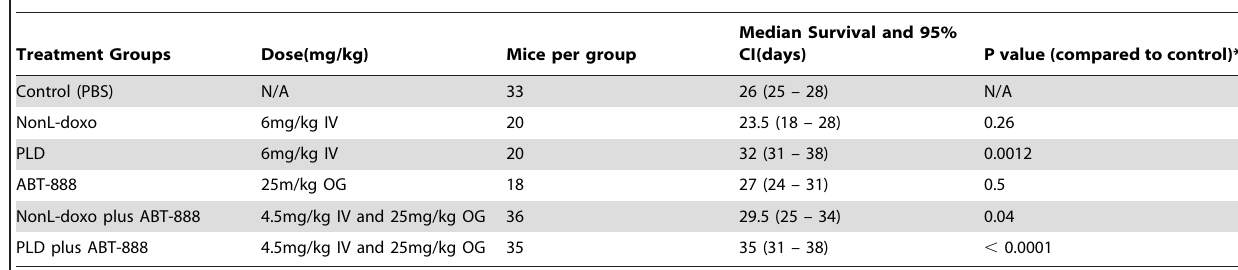
Median Survival of an intracranial breast cancer model treated with Control (PBS), non-liposomal doxorubicin (NonL-doxo) versus PEGylated Liposomal Doxorubicin (PLD). *P value for NonL-doxo vs. PLD =0.0002; p value for NonL-doxo/ABT-888 vs. PLD/ABT-888=0.006. Abbreviations: IV, intravenous; OG, oral gavage.